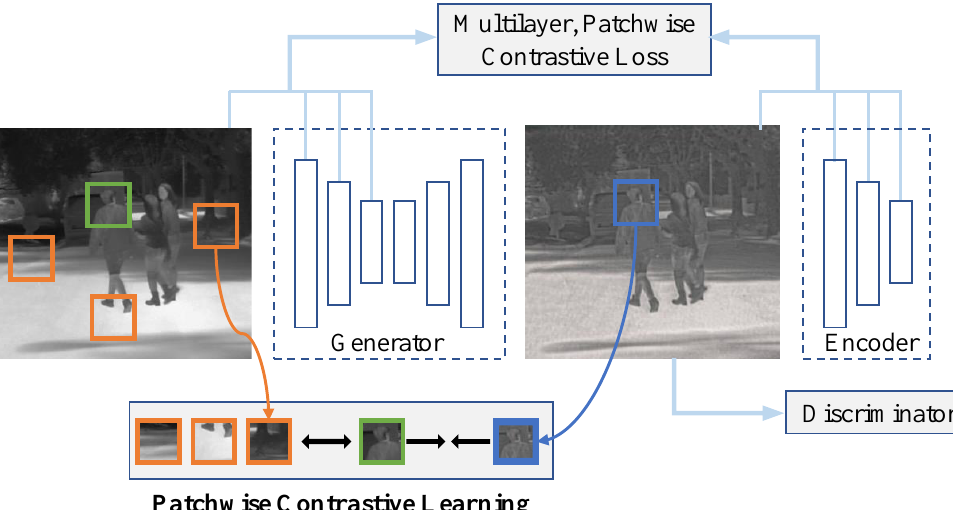
Figure 4. Illustration of the patchwise contrastive learning progress used in [56]. A generated intermediate image patch (marked with a blue box) is strongly associated with the corresponding patch (colored green) in the source image via contrastive learning, while disassociated from the other random patches. In this way, the generated intermediate domain is forced to preserve the source local content.